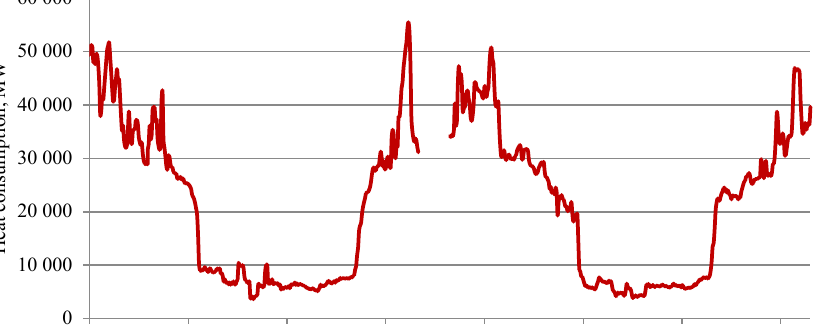
Fig. 4. 2019- and 2020-year